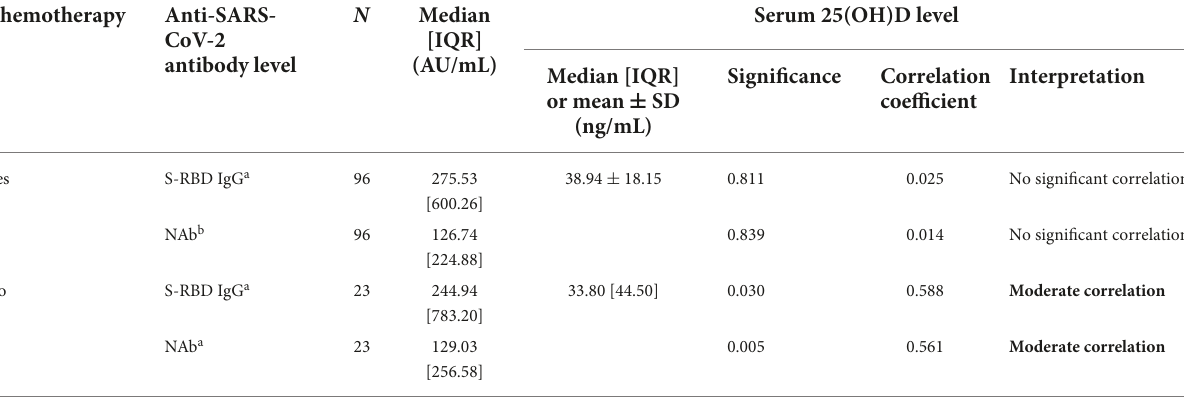
TABLE 4 The correlation between serum 25(OH)D levels and anti-SARS-CoV-2 antibody (anti-SARS-CoV-2 S-RBD IgG and NAb) among subjects received chemotherapy and non-chemotherapy.